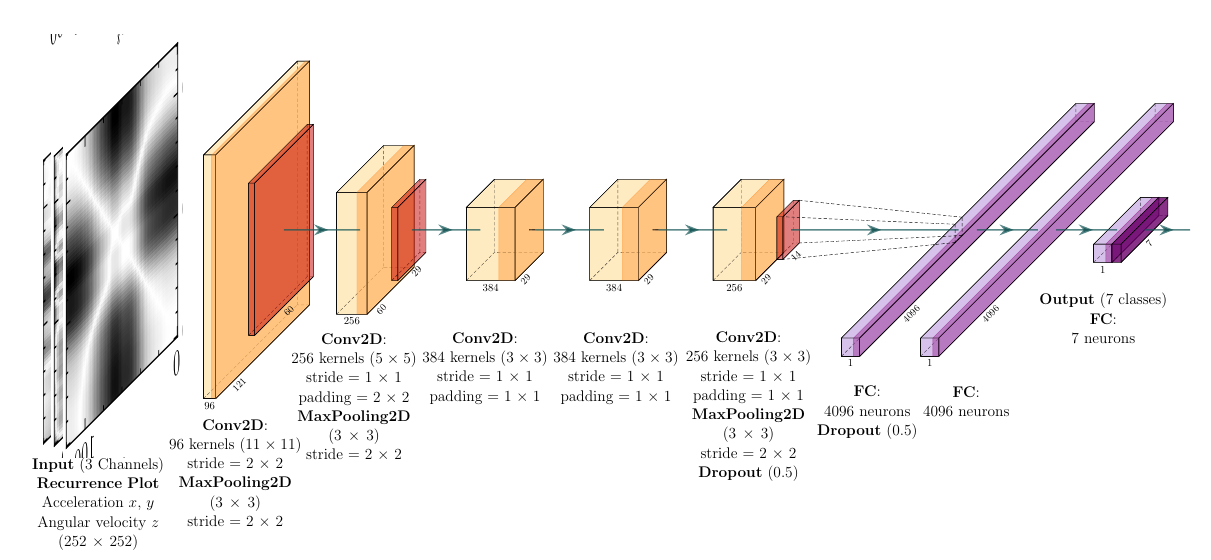
Figure 3. 2D-AlexNet architecture. Each block describes the parameters assigned to the respective layers, as for blocks “Conv2D” and “MaxPooling2D”, where the first value corresponds to the size of the